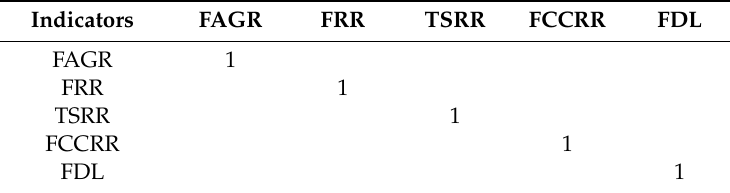
Table 2. Scoring for forest degradation indicators (only filling in the part above or below the diagonal line). Indicators FAGR FRR